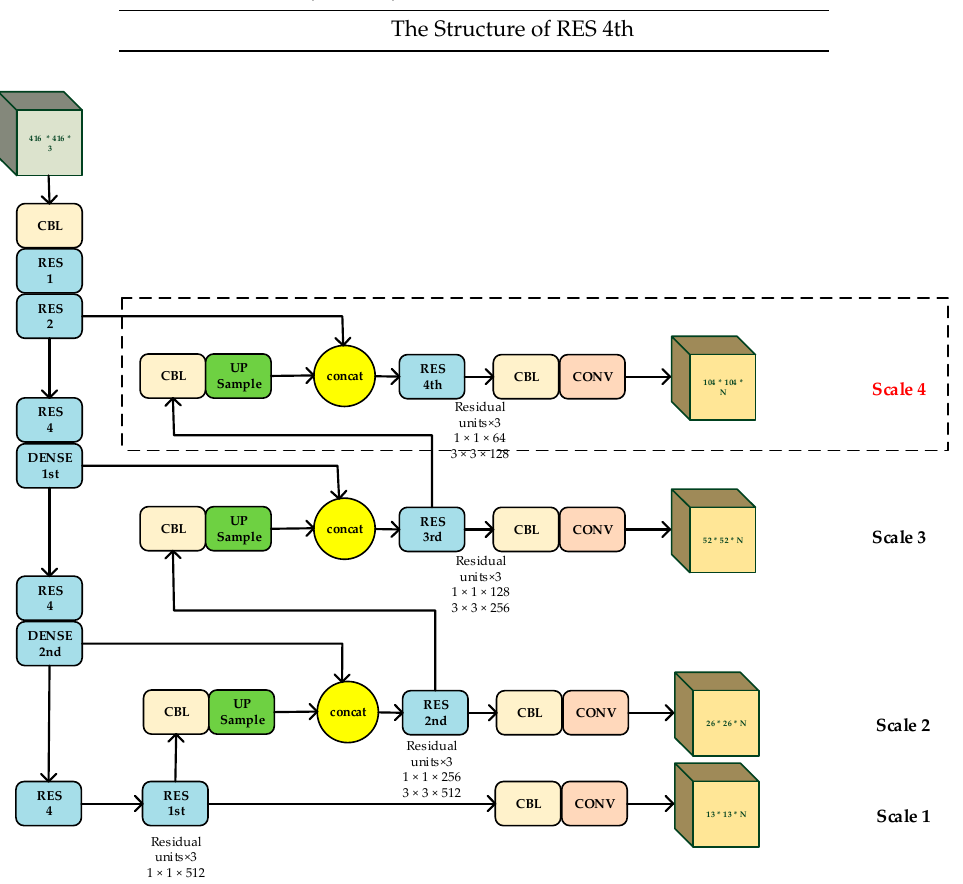
Figure 4. The Structure of the proposed network.